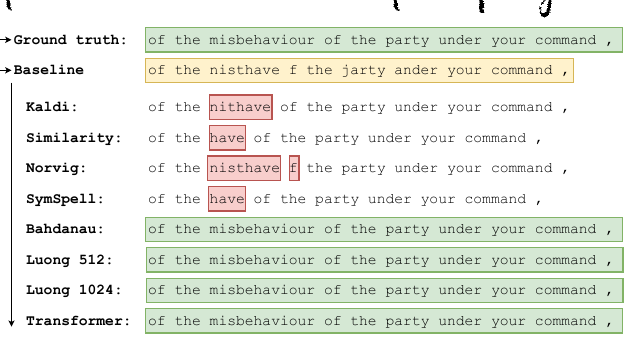
Figure 21. Correction sample in the Washington